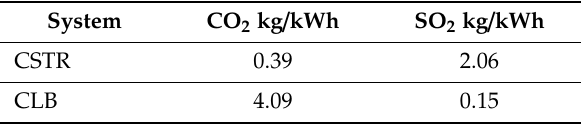
Table 7. Power of CSRT and CLB in capture CO 2 and SO 2